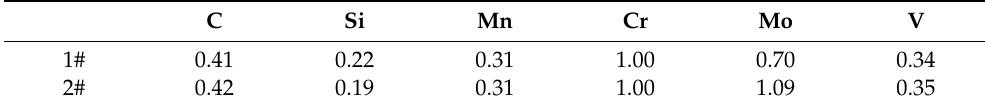
Table 1. The composition of 1400 MPa-grade high-strength bolt steel (mass, wt%). C Si Mn Cr Mo